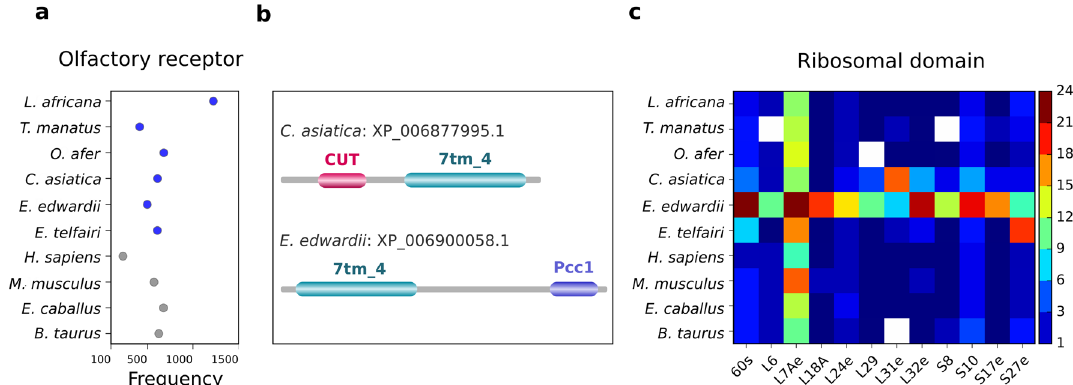
Figure 7. Domains that are unusually represented in Afrotherian proteomes. ( a ) Dot plot showing the frequency of olfactory receptor domain containing proteins in various Afrotherian species (in blue) and reference species (in grey). Frequency is normalized by the total number of proteins with functional domain assignments. ( b ) Novel domain architectures of olfactory receptor domain (7tm_4) with CUT domain observed specifically in C. asiatica (XP_006877995.1) and Pcc1 domain in E. edwardii (XP_006900058.1). ( c ) Heatmap shows the abundance of ribosomal domain containing proteins in various species. Color scale (blue to